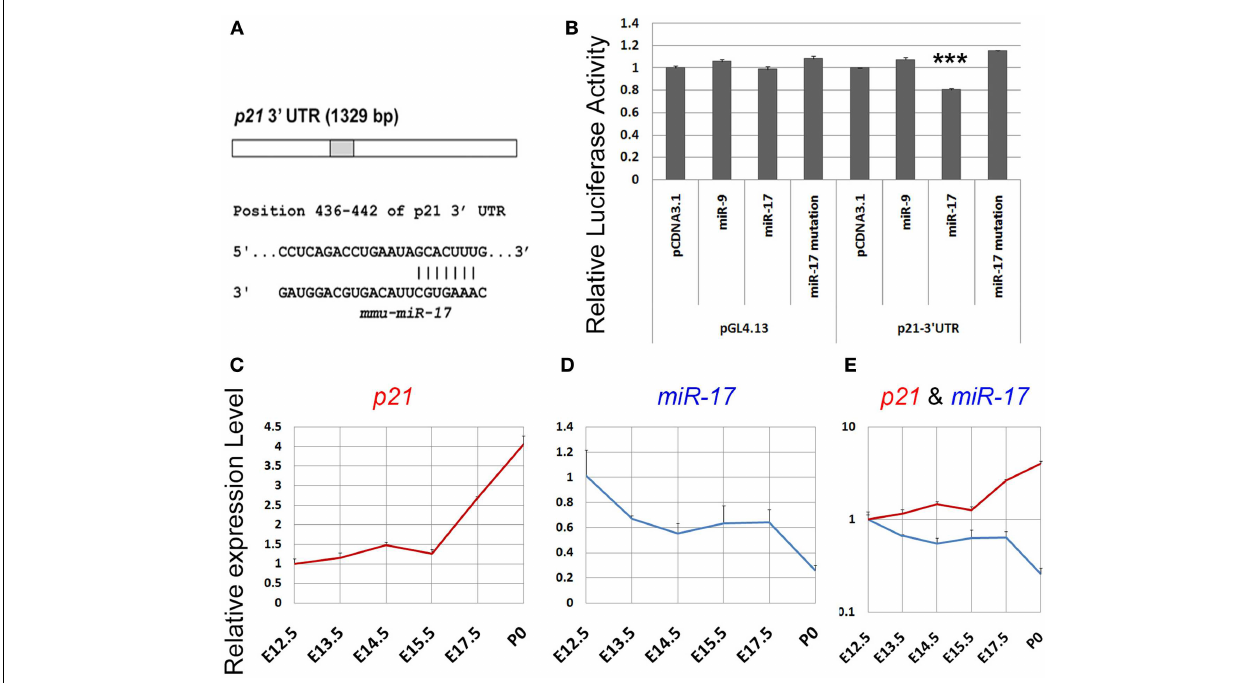
level of p21 in the mouse cortex continuously increased from E12.5 to P0. (D) The expression level of miR-17 in the mouse cortex continuously decreased from E12.5 to P0. (E) A combined view of the expression levels of p21 and miR-17 at different developing stages. Data are presented as mean ± SEM; n = 3; *** p < 0.001.